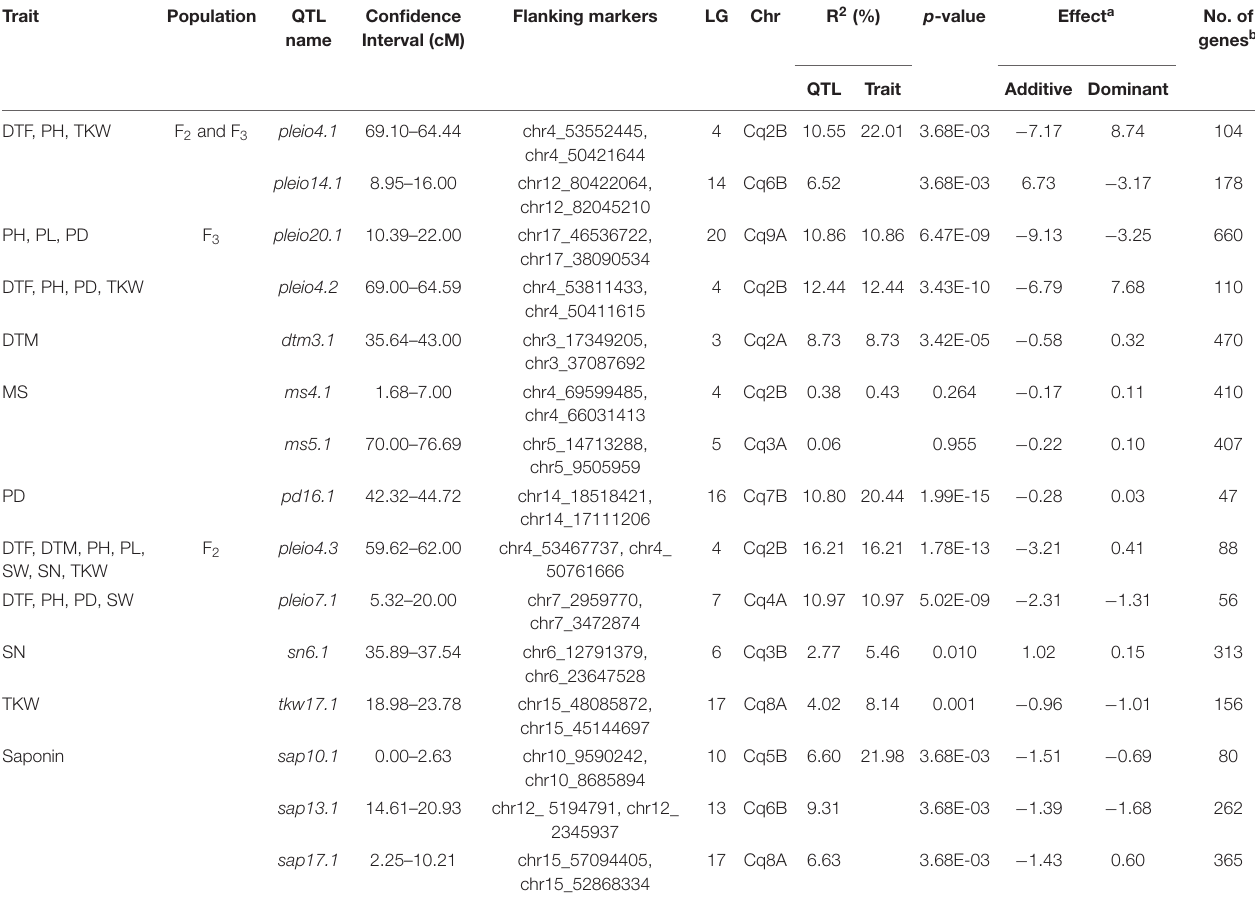
TABLE 4 | Summary statistics of quantitative trait loci (QTL) mapping with the F 2 population and 328 F 3 families.